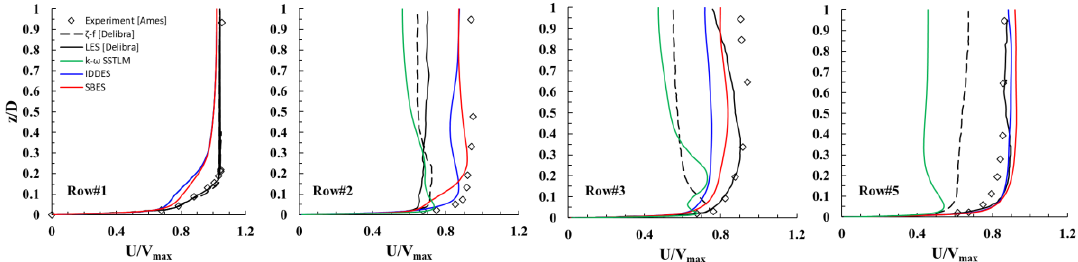
Figure 5. Time-averaged streamwise velocity profiles normalized by V max along line A at rows 1, 2, 3, and 5.